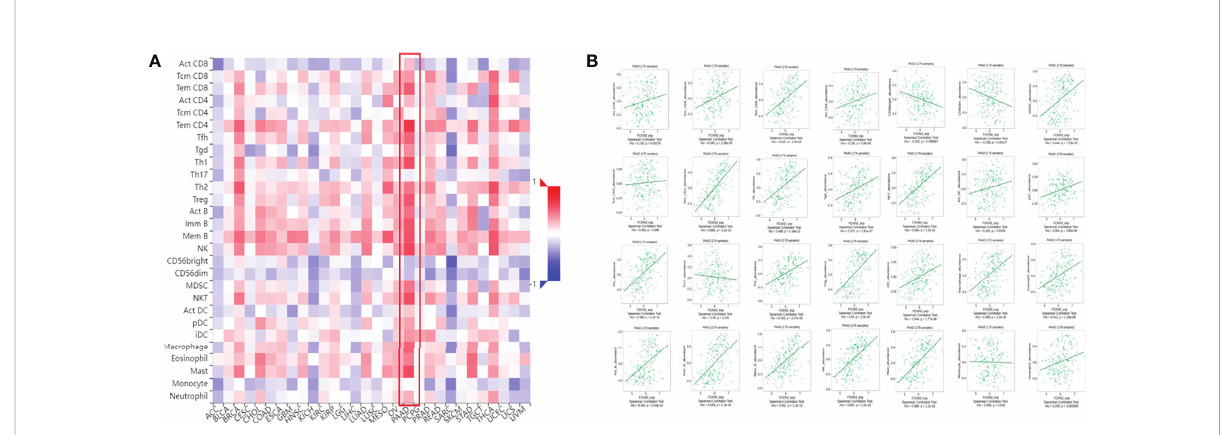
FIGURE 8 (A) The relationship between FOXN3 gene expression and TIICs in pan-cancer. (B) Relationship between FOXN3 expression and tumor- in fi ltrating immune cells in